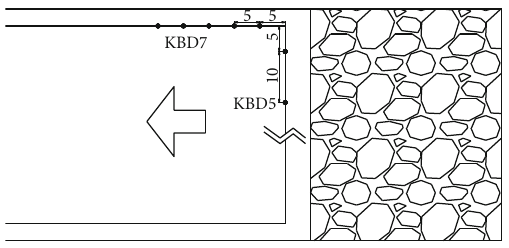
Figure 18: Schematic diagram of receiving antenna